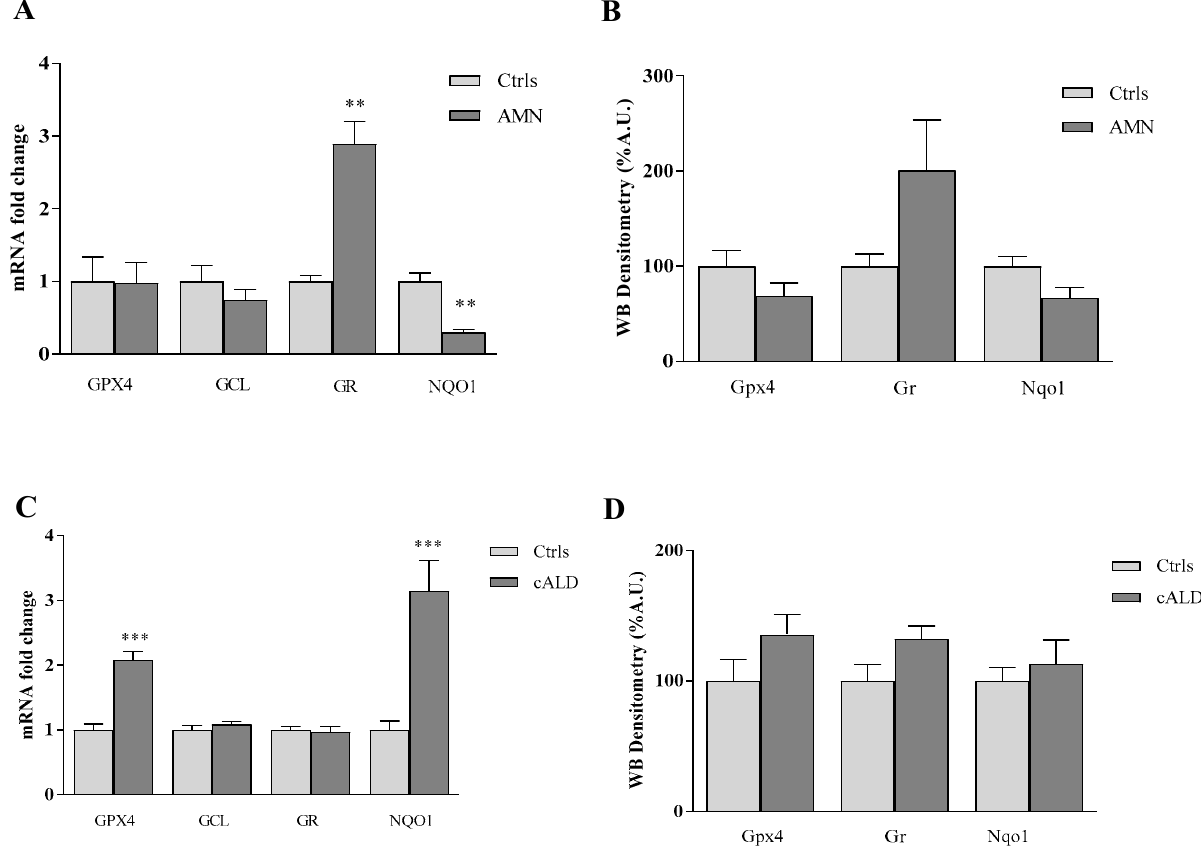
Figure 1. Antioxidant enzymes expression in fibroblasts of patients with AMN ( A , B ) and cALD ( C , D ). ( A , C ) qRT-PCR analyses of GPX4, GCL, GR, NQO1 mRNA transcripts. ( B , D ) Densitometric analysis of Gpx4, Gr and Nqo1 protein levels. Experiments were conducted in triplicates and values expressed as mean ± SEM. ** p < 0.01, *** p < 0.001, compared to control’s